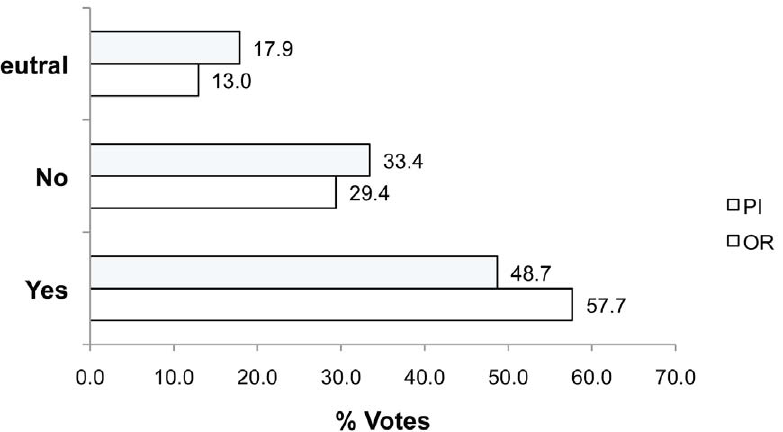
Figure 4. Percent of Yes, No and Neutral votes in response to Q2. Question 2: Do you agree with the investigator’s decision to use 20 trout (in an approved protocol) instead of pursuing the possibility of using just 15?